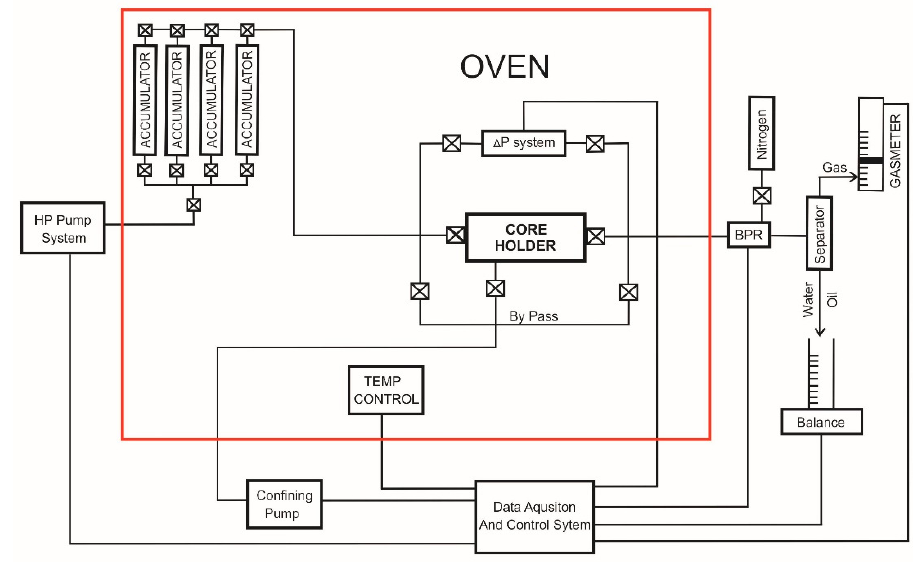
Figure 2. Diagram of the AFS-300 coreflooding system.